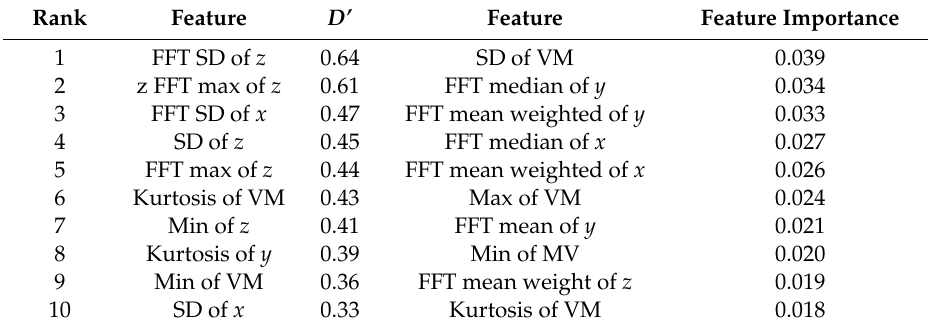
Table 3. Top 10 features ranked high in d ’ score and feature importance to di ff erentiate “carried” vs. “ambulation”.